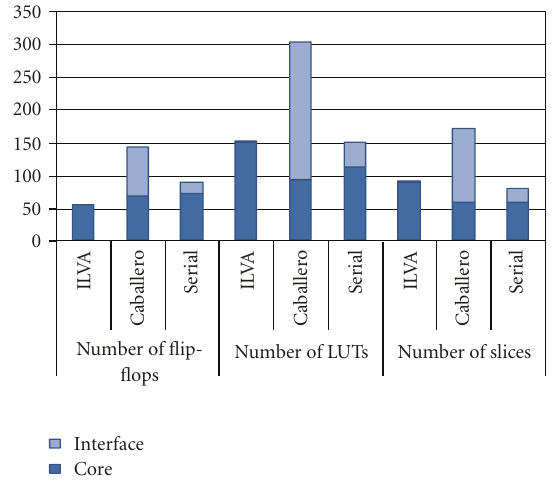
Figure 20: Area utilization per node compared to ILVA and Caballero architectures shows that nodal interface is kept at minimum which improves the overall logic utilization. The vertical axis reflects the number of flip-flops, LUTs, or slices of the three di ff erent architectures.